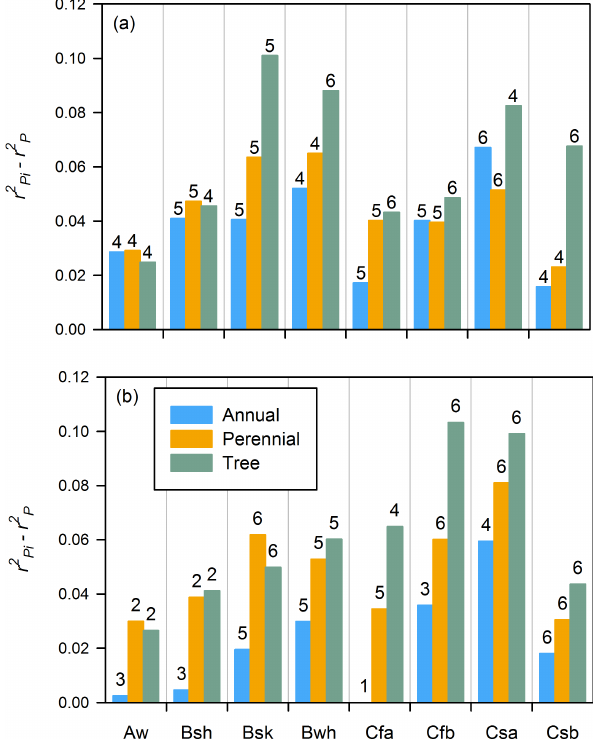
for correlation be- P for P i Fig. 12. Differences between r 2 and r 2 for all climate types, P i P vegetation types and two soil types: (a) K = 0 . 1md − 1 and (b) K = 1 . 0md − 1 . The data labels indicate the method of annual rain- fall aggregation resulting in a highest differences between r 2 and P : 1=underline all rainfall events, 2= a daily rainfall threshold r 2 P i greater than 20mm, and 3 to 6 all above a rainfall threshold us- ing a moving average, where 3=7-day window and a threshold of 2.5mmd − 1 , 4 = 14-day window and a threshold of 5mmd − 1 , 5 = 21-day window and a threshold of 2.5mmd − 1 , and 6 = 21-day window and a threshold of 5mmd − 1